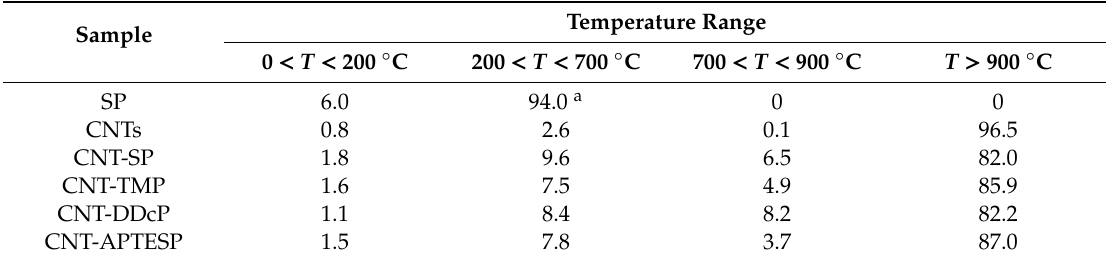
Table 1. Mass losses (mass %) for CNTs and CNT-PyC adducts, from thermogravimetric analysis (TGA)